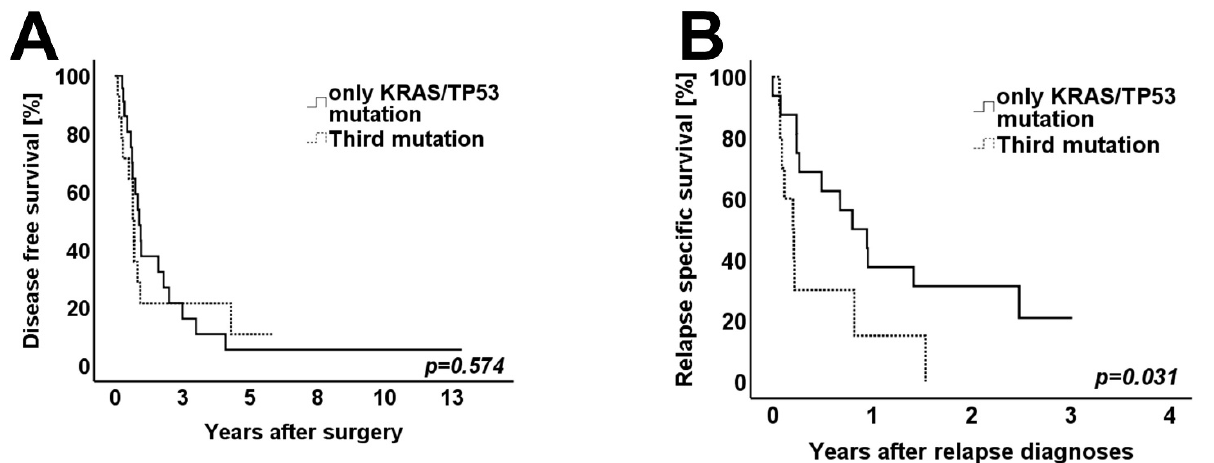
Figure 5. Kaplan–Meier survival curves for: ( A ) Disease-free survival of patients with any third mutation and patients harboring KRAS mutation and/or TP53 mutations ( n = 39). ( B ) Relapse-specific survival of patients with any third mutation and patients harboring KRAS mutation and/or TP53 mutations ( n = 39). Log-rank test was used to test for significance. p -value < 0.05 indicates significance.